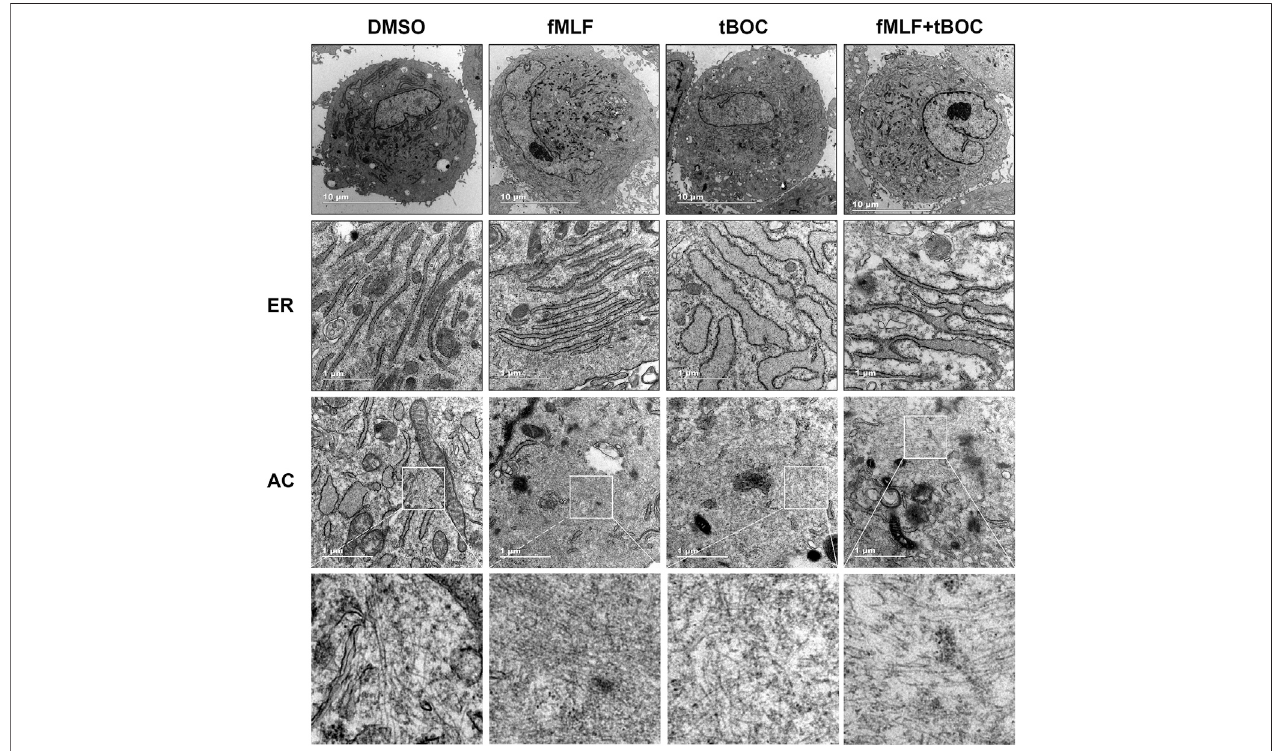
FIGURE 5 | Representative transmission electron microscopy of HutSMCs with and without treatment with fMLF or tBOC. Increasing levels of magni fi cation are indicated by scale bars, 10 and 1 μ m. ER: endoplasmic reticulum; AC: actin fi laments.